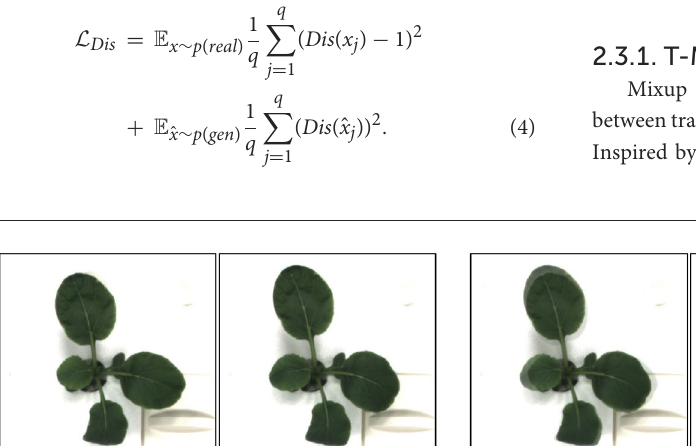
FrontiersinPlantScience